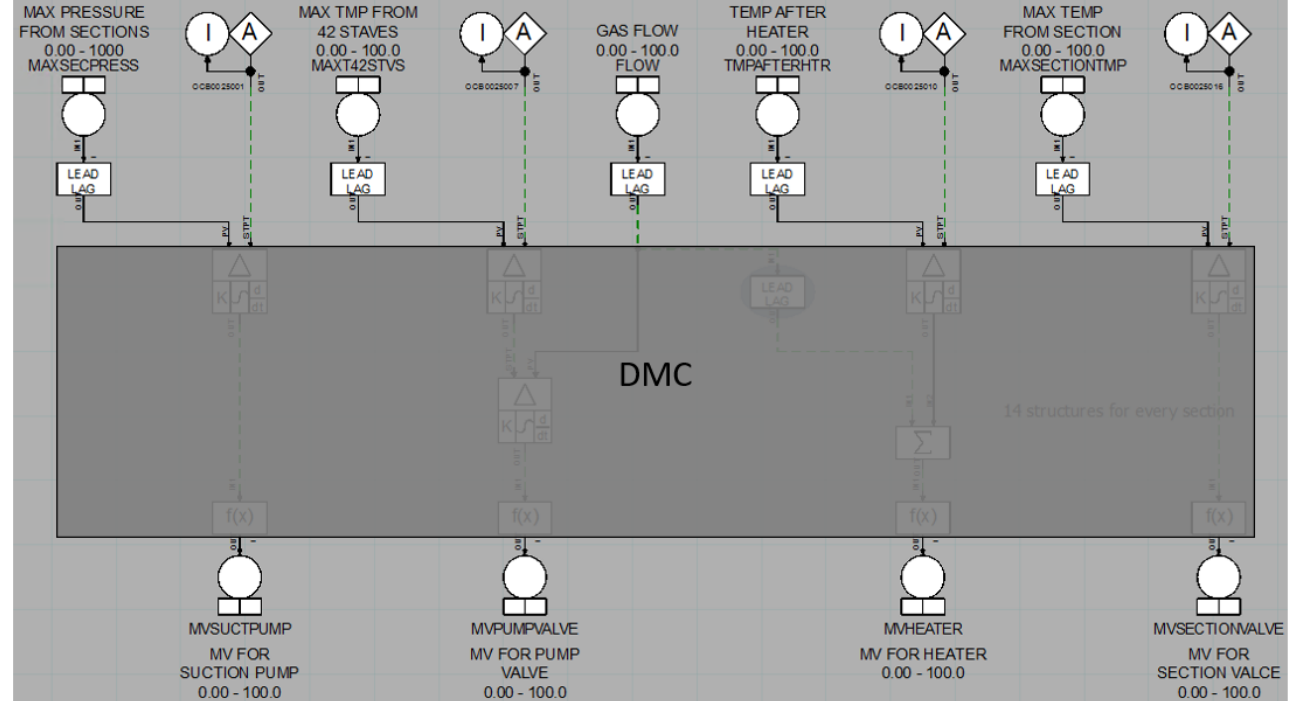
Figure 9. The thermal system: the advanced structure version 2.